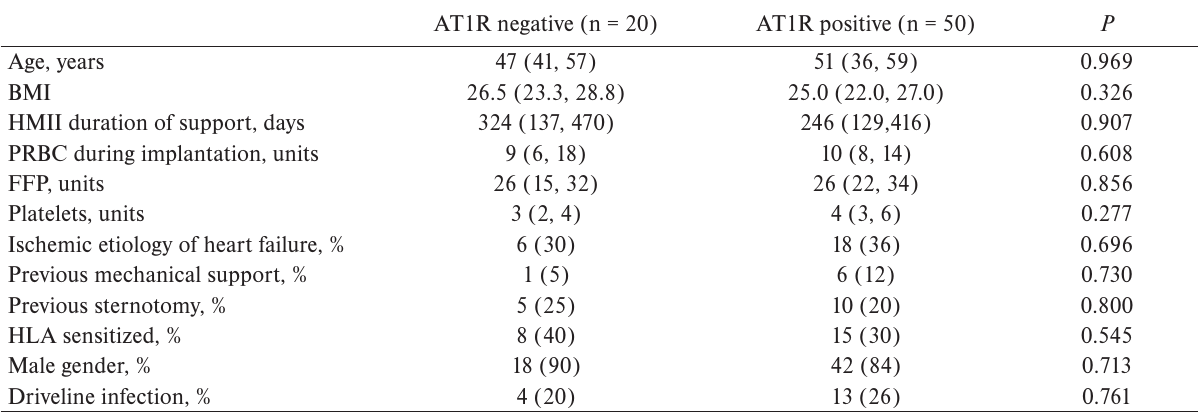
Table 2. Comparison of AT1R negative patients versus those who became AT1R positive during HeartMate II